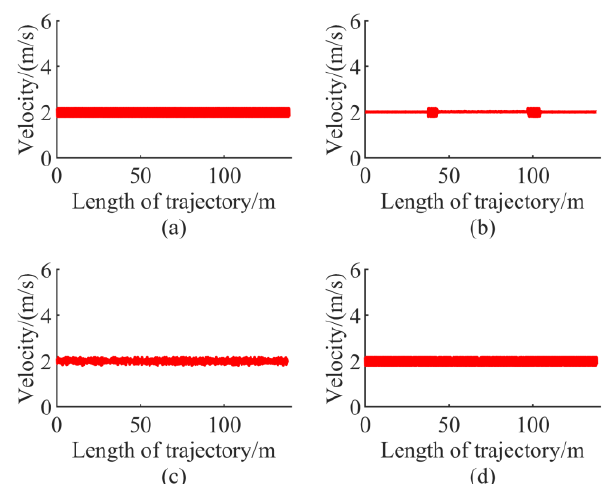
Figure 39. The trajectory of the final set of comparison. The red line is the trajectory. The blue line is the reference path. ( a ) LMPC. ( b ) LEMPC. ( c ) NMPC. ( d ) NEMPC.